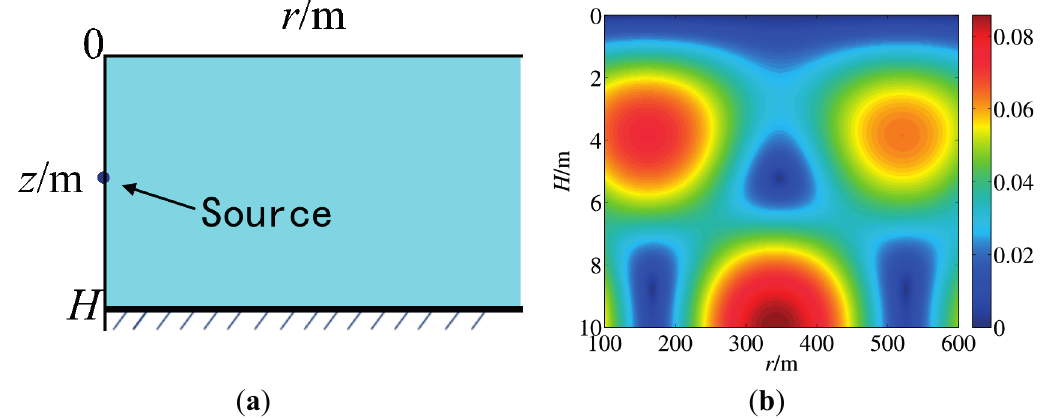
Figure 1. ( a ) The sketch of underwater circumstances; ( b ) The pressure field intensity generated by a